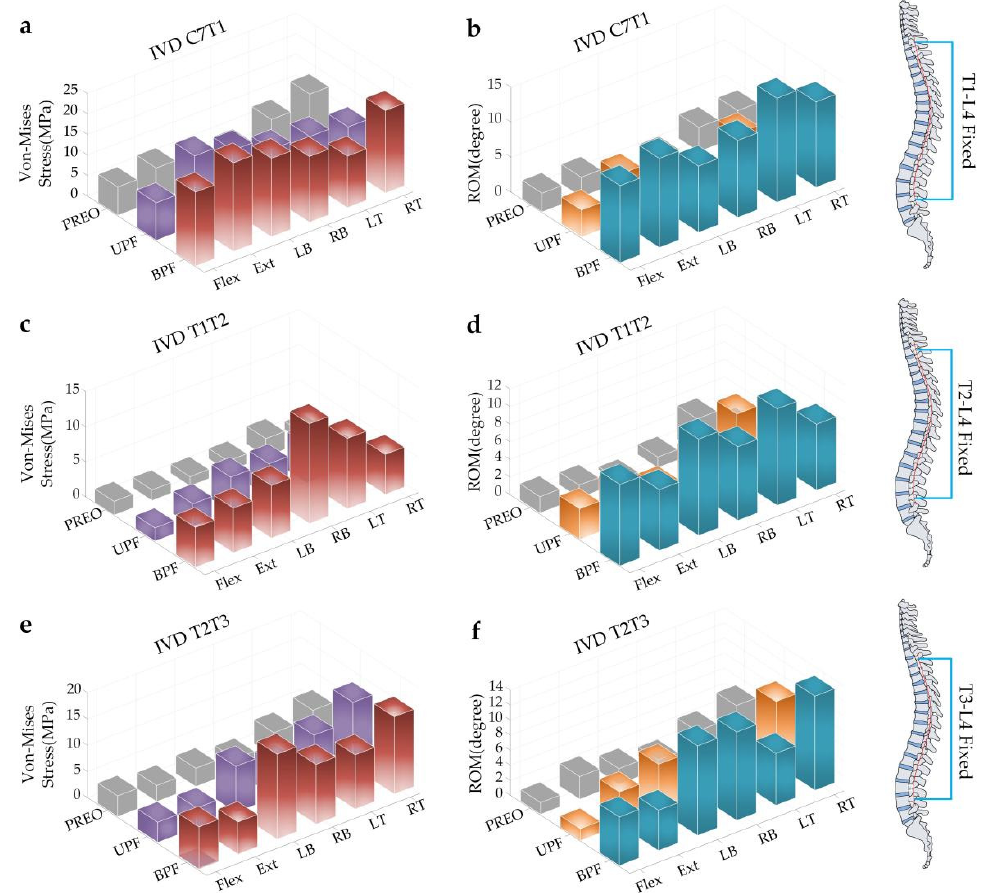
Figure 8. Stress and ROM of IVD in SAS with different surgical procedures under angular displace- ment. ( a ) The stress changes of IVD C7T1; ( b ) The ROM changes of IVD C7T1; ( c ) The stress changes of IVD T1T2; ( d ) The ROM changes of IVD T1T2; ( e ) The stress changes of IVD T2T3; ( f ) The ROM changes of IVD T2T3.